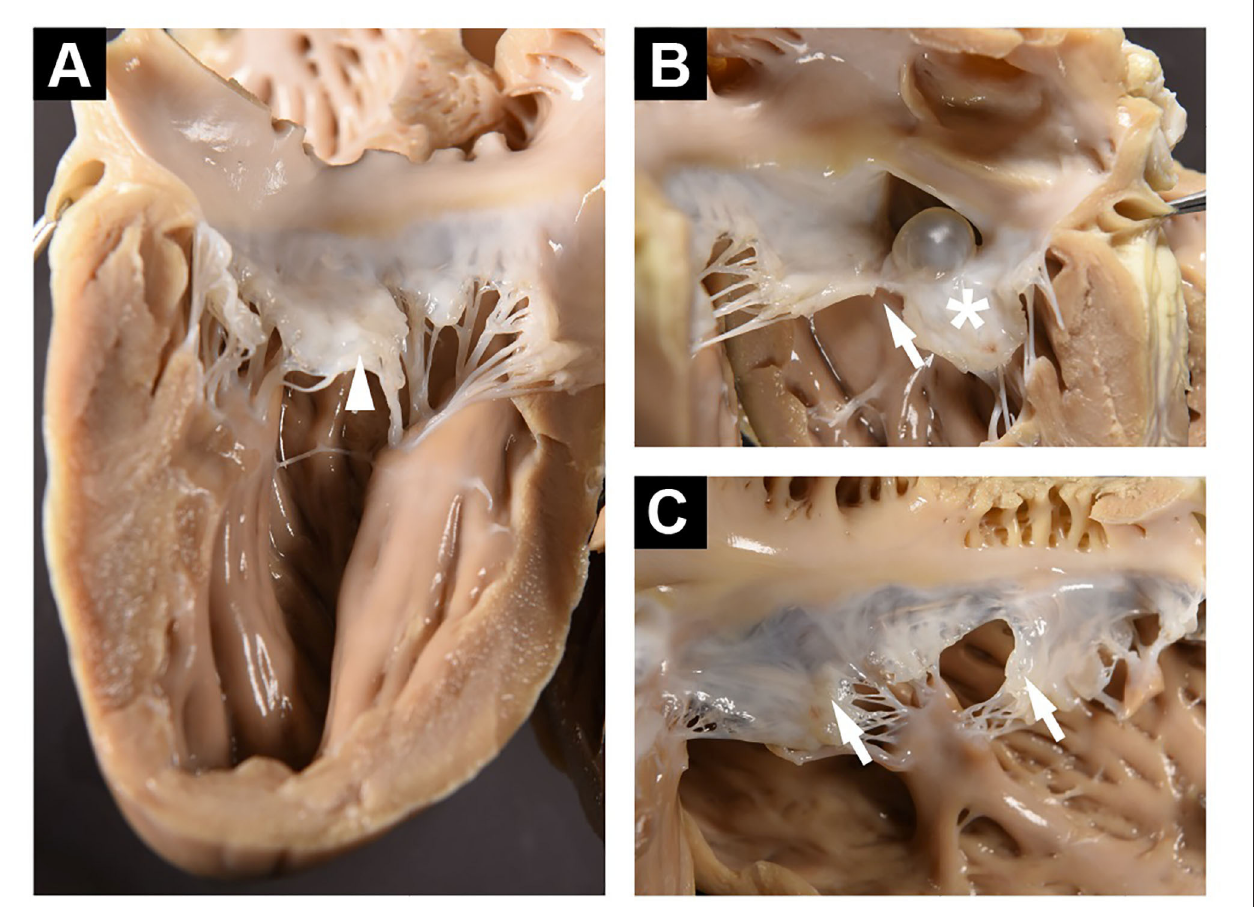
FIGURE 3 | (A) Left ventricular free wall and posterior mitral valve showing enlarged middle scallop (arrowhead). (B) Septum as viewed from the left ventricle showing ASD and cyst. The anterior mitral leaflet is exhibiting diffuse thickening (*), and A1/A2 clefting (arrow). (C) Right ventricular free wall and tricuspid valve with small nodular thickenings at the free margin